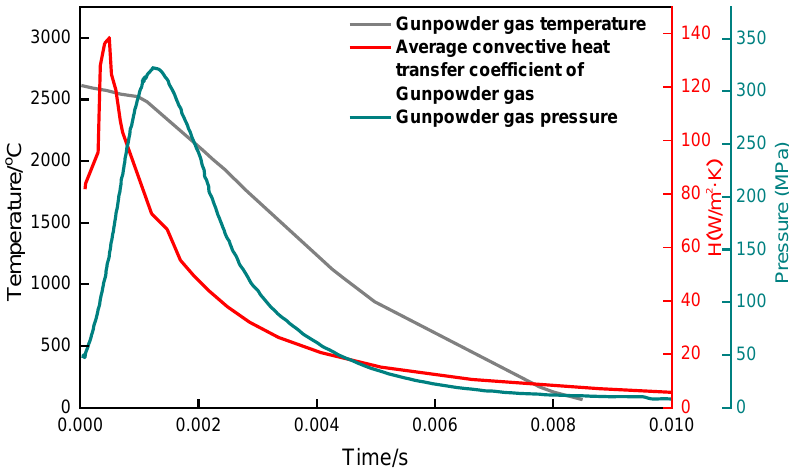
Figure 3. Variation curves of gunpowder gas temperature, average convective heat transfer coefficient and gas pressure with gun firing time.